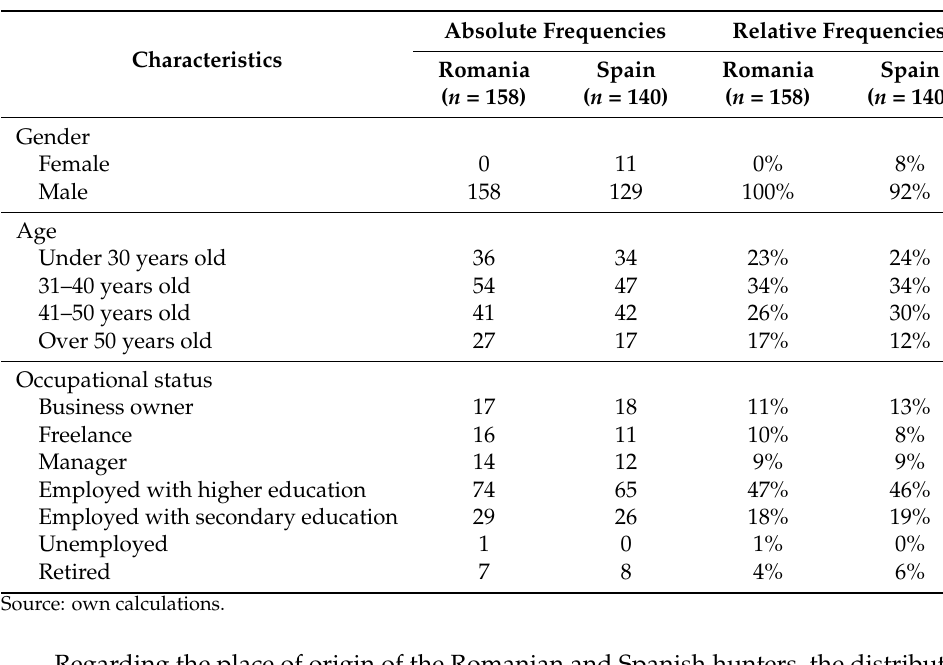
Table 1. Sample description—general socio-demographic data.